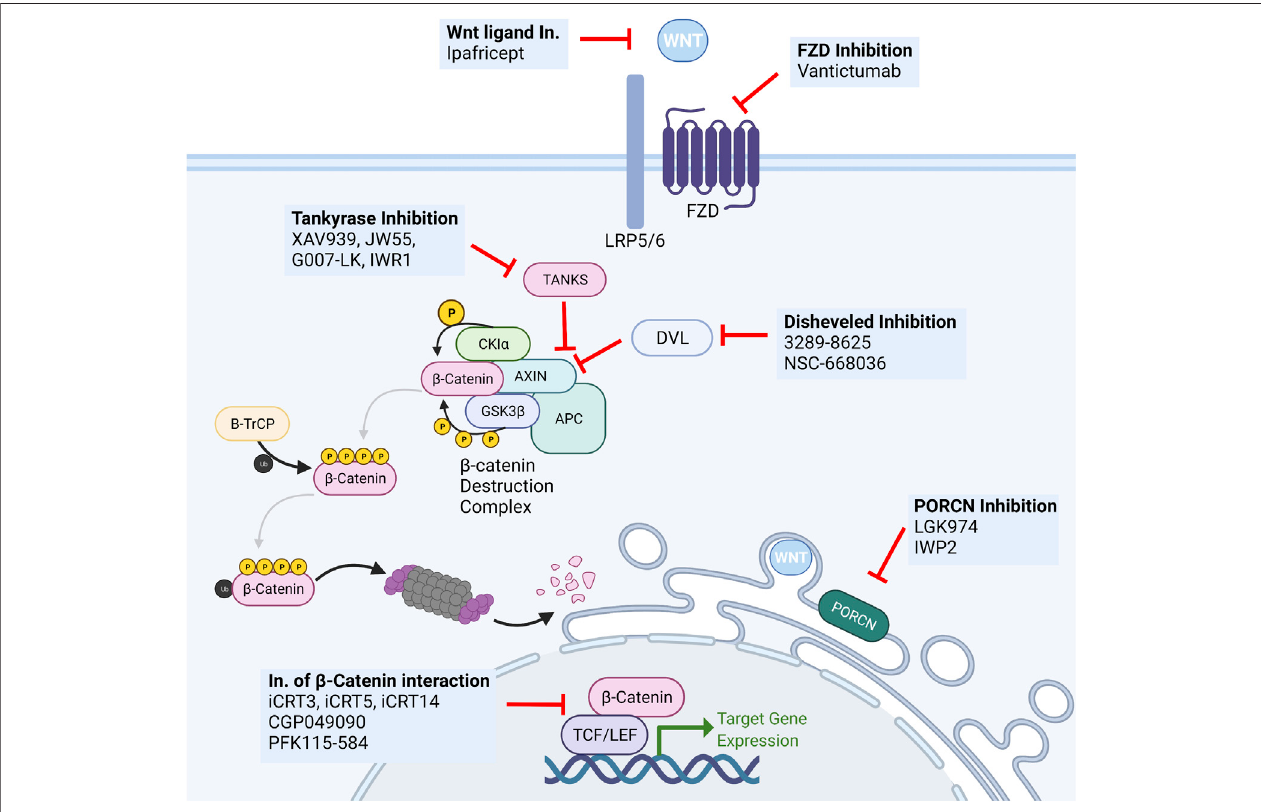
FIGURE 5 | Overview of Wnt targeting drugs. Several classes of biological and small molecule Wnt-targeting drugs have been developed and studied for anti- cancer activity. The most important include monoclonal antibodies targeting secreted Wnt ligands (Ipafricet) or their receptors (Vantictumab), tankyrase inhibitors (XAV939, JW55, G007-LK, IWR1), disheveled inhibitors (3289 – 8625, NSC-668036), PORCN inhibitors (LGK974, IWP2), and inhibitors of the β -catenin:TCF/LEF transcriptional complex (iCRT3. iCRT5, iCRT14, GGP049090, PFK115-584).